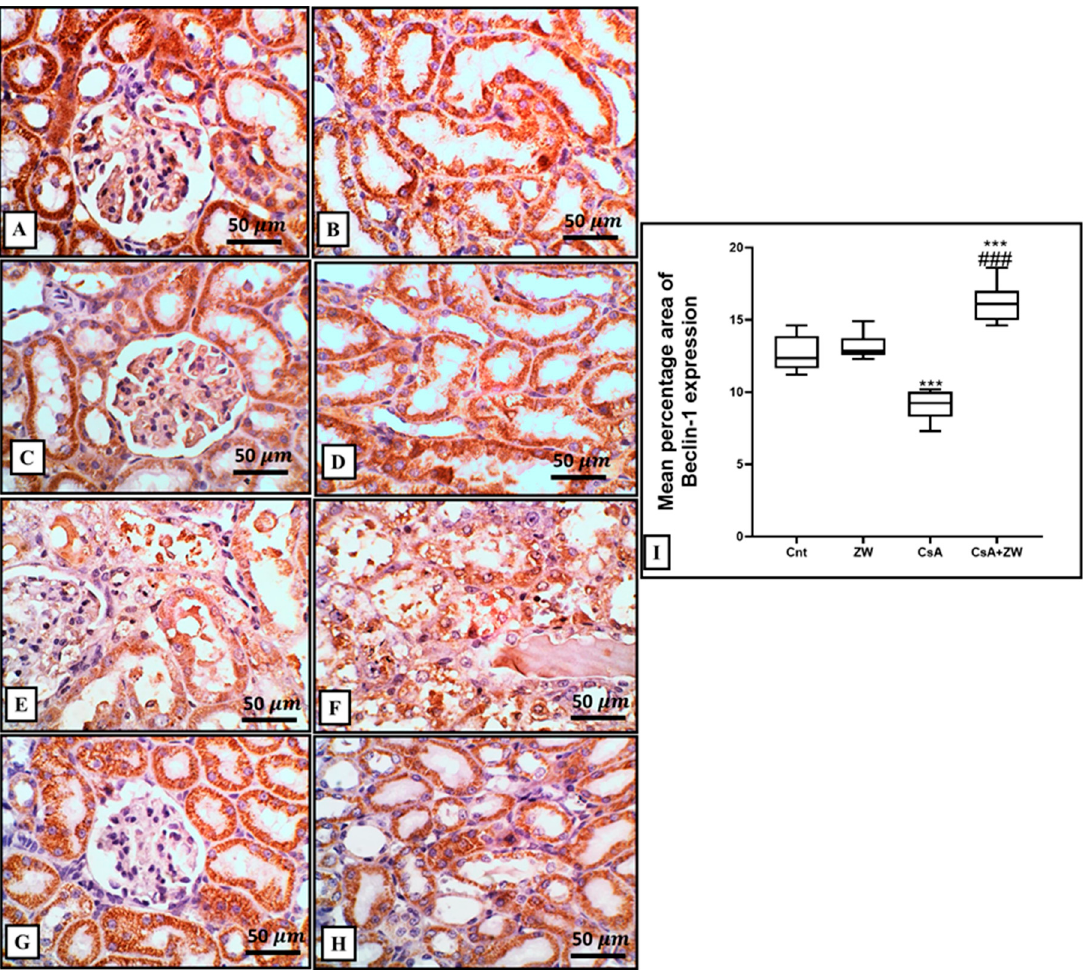
Figure 8. Immunohistochemical investigation of beclin-1 expression and localization in the kidney. ( A – D ) The control and ZW groups show strong cytoplasmic expression in cortical tubules, with mild glomerular expression and diffuse expression in the cytoplasm of medullary tubules. ( E , F ) The CsA group shows diffuse, faint expression in the cytoplasm of necrotic and vacuolated cortical and medullary tubular cells and in the cytoplasm of vacuolated and intraluminal cells, with faint minimal expression in the glomerulus. ( G , H ) The CsA + ZW group shows diffuse, high cortical and medullary tubular expression, with little glomerular expression. ( I ) Renal Becline_1 histogram percentage area. *** p < 0.001 vs. control ; ### p < 0.001 vs. CsA. Image magnification = 400 × ; scale bar = 50 µ